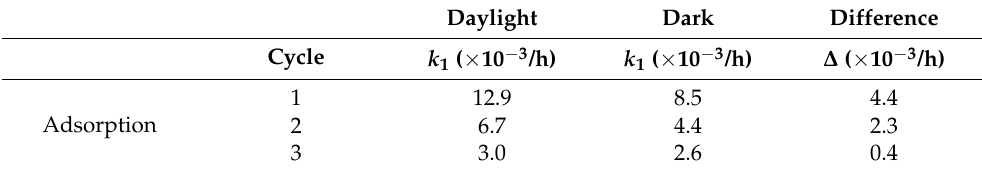
Figure 8. Adsorption kinetics of MB removal in ( a ) daylight and ( b ) dark conditions. Table 1. Adsorption kinetics of MB removal (daylight and dark